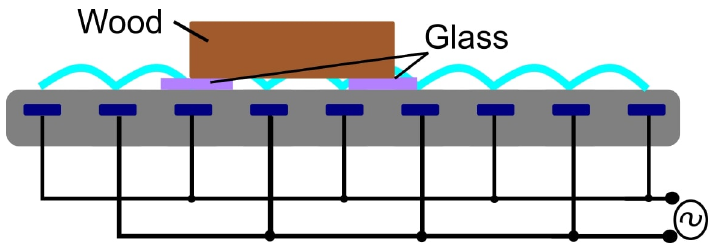
Figure 2. Schematic setup of the DCSBD electrode.